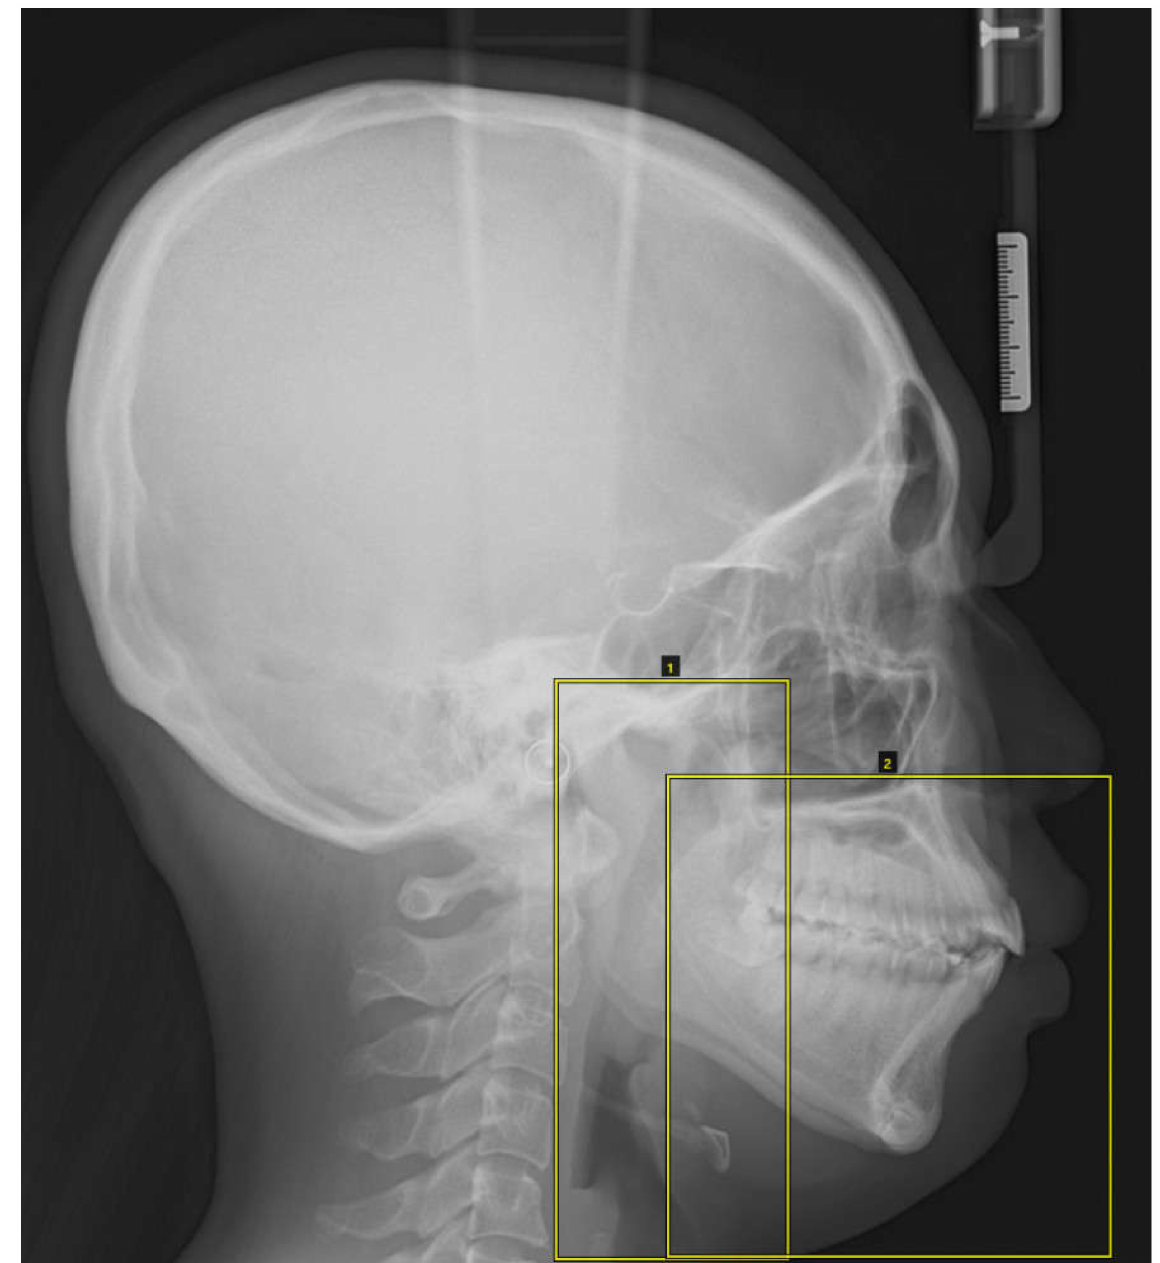
Figure 2. The lateral cephalometric images were masked with two square markers: a left long square containing the condylar process, coronoid process, mandibular ramus, and airway space and a right square containing the dentoalveolar region, maxilla, mandibular body, and lower facial soft